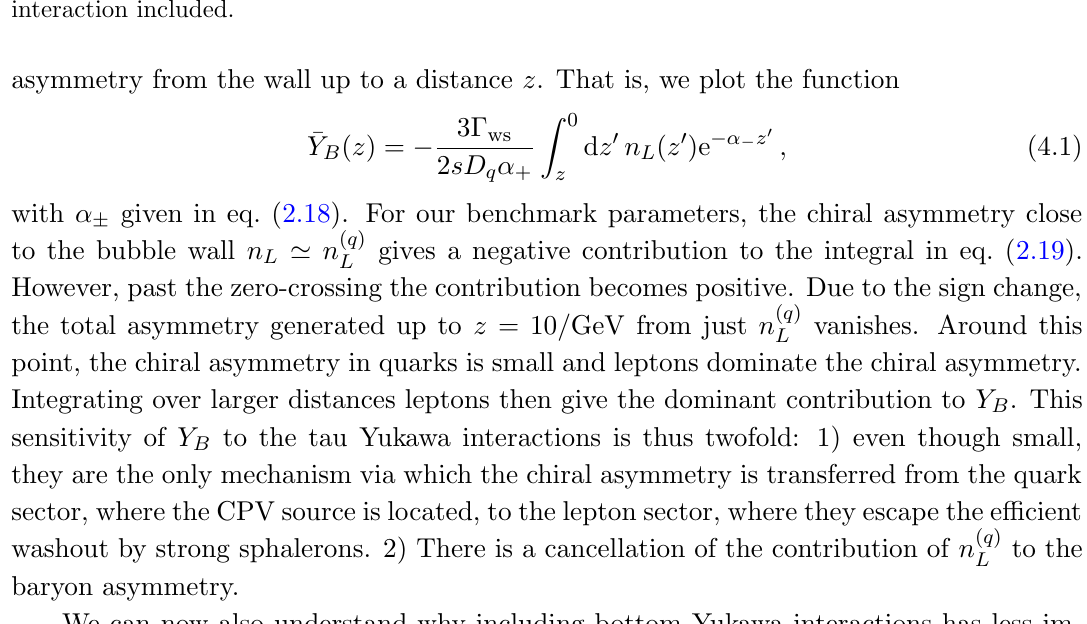
Figure 3 . Y B as a function of velocity v w with (solid blue) and without (dashed orange) lepton interaction